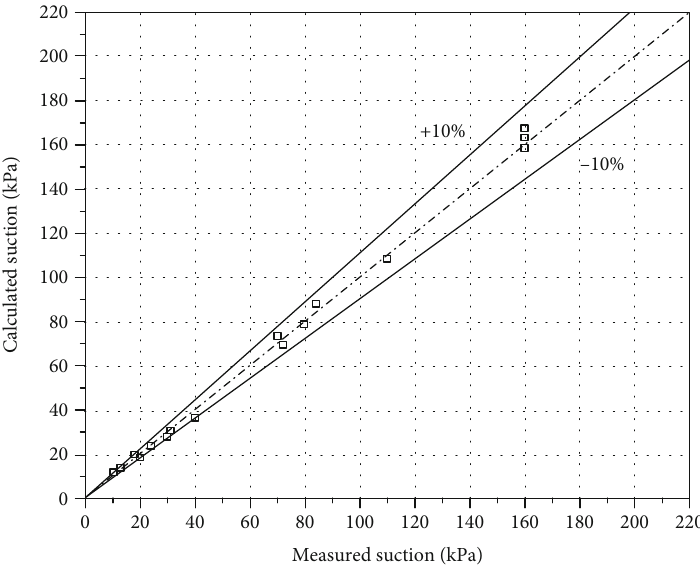
Figure 5: Comparison between experimental and predicted